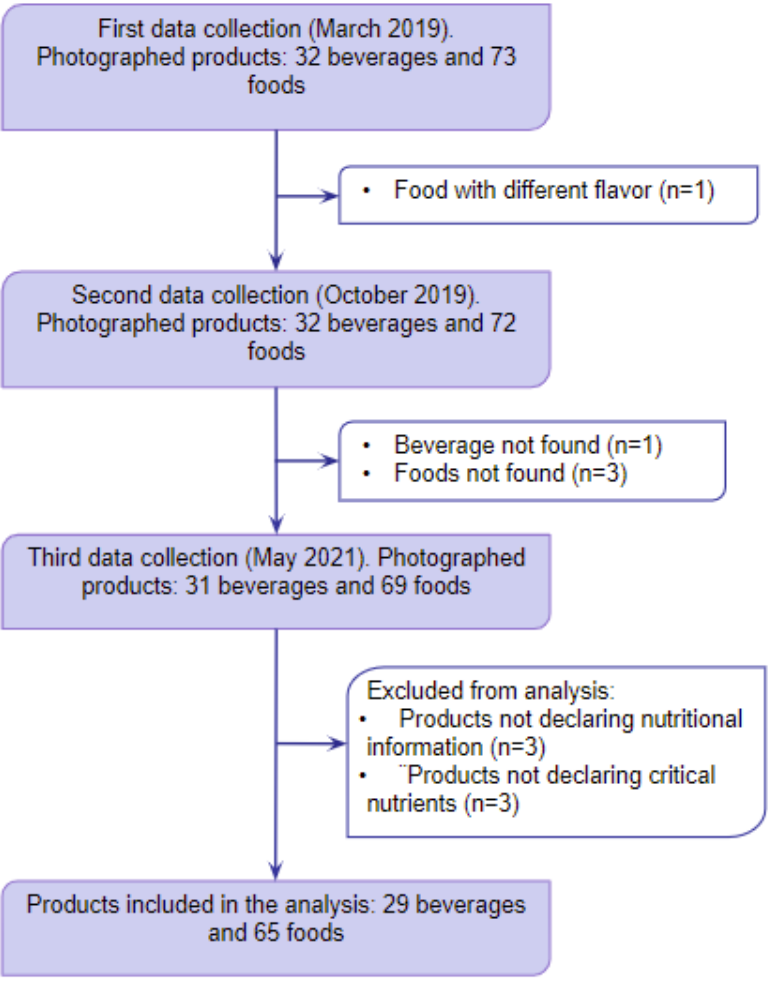
Figure 1. Sample selection process.